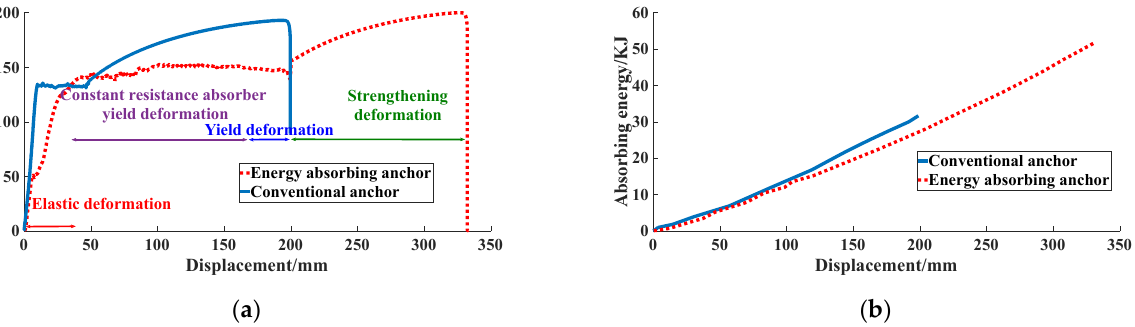
Figure 8. The comparison of the mechanical property curves ( a ) bearing capacity-displacement curve; ( b ) energy absorption characteristic curve. Table 3. Comparison of the mechanical properties of the conventional anchor and energy absorbing anchor. Anchor